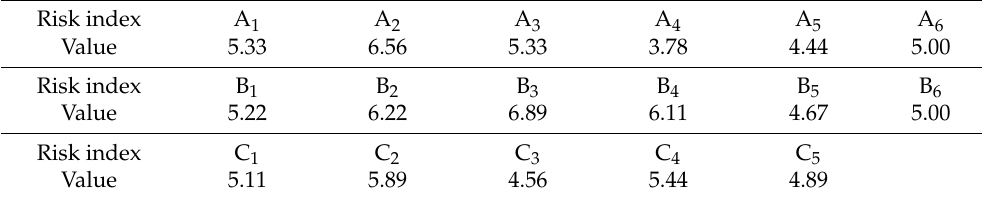
Table 2. Scores of ICCL safety supervision index.